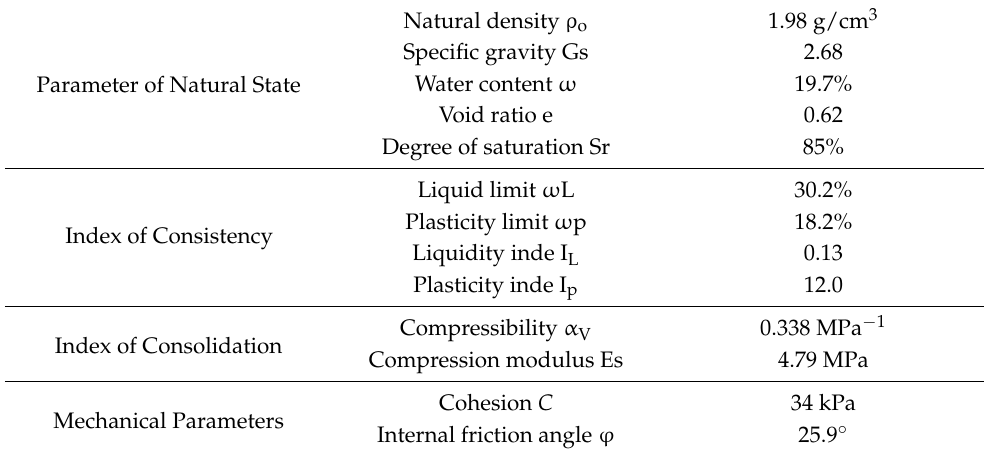
Table 1. Physical and mechanical parameters of soil. Parameter of Natural